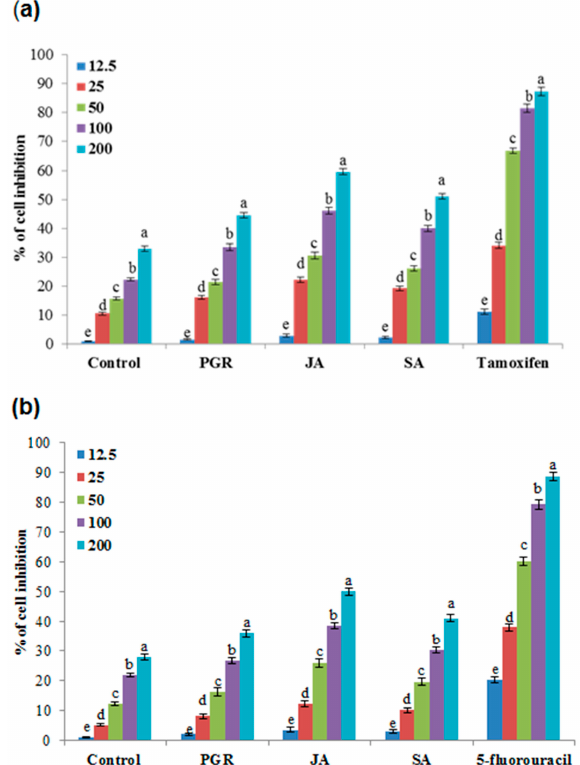
Figure 5. Percent cell inhibition of PGR-, JA- and SA-treated cell suspension culture extracts of P. multiflorum on MCF-7 and HT-29 cell lines ( a ) MCF-7; ( b ) HT-29. Means ± standard deviation of three replicates followed by the same letters are not significantly different according to DMRT at p ≤ 0.05.